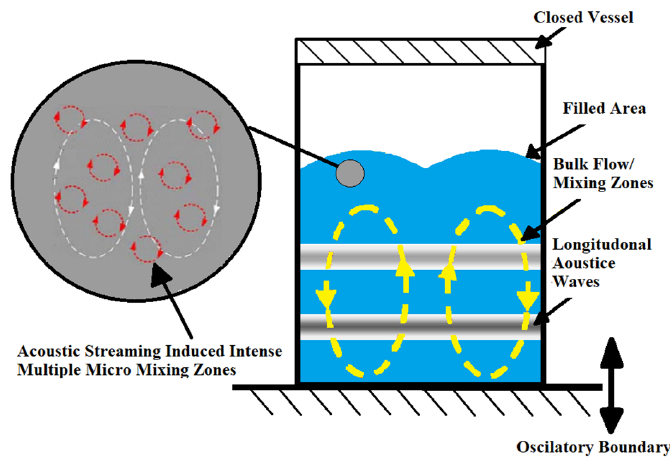
Figure 2. RAM mixing mechanism and mix material motion schematic.